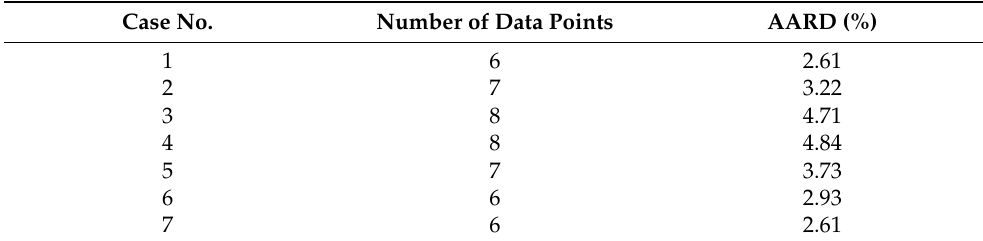
Table 7. AARD calculated in all case simulations. Case No. Number of Data